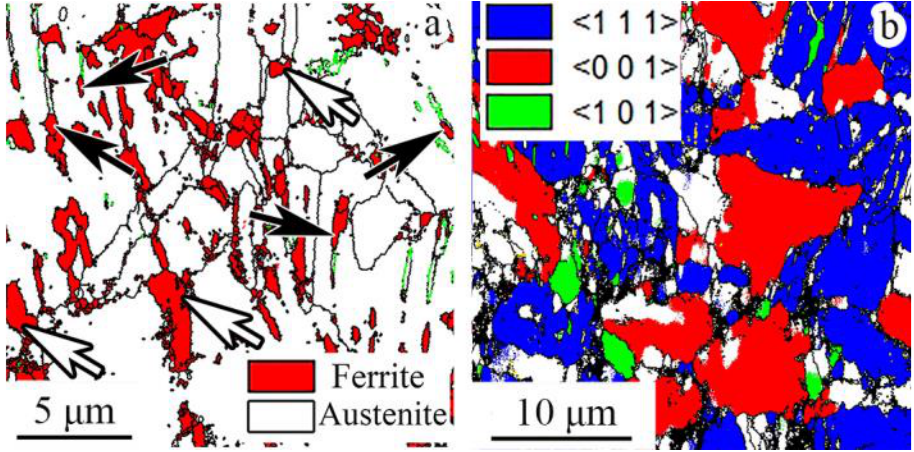
Figure 10. ( a ) The phase and ( b ) crystal direction maps of the rod center after a 60% reduction. High-angle boundaries (misorientation more than 15 ◦ ) are marked in black and green, respectively. In ( a ), twin ( Σ 3) boundaries are marked in green.